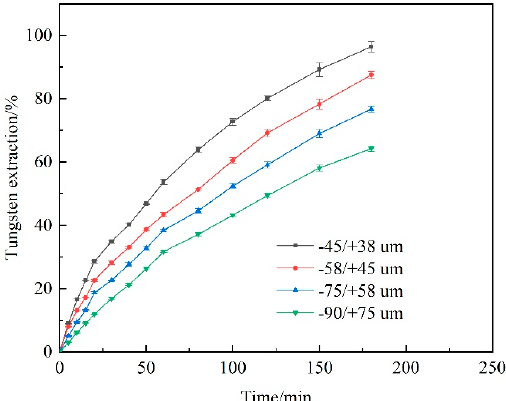
Figure 12. Effect of mineral particle size on the leaching efficiency of tungsten.